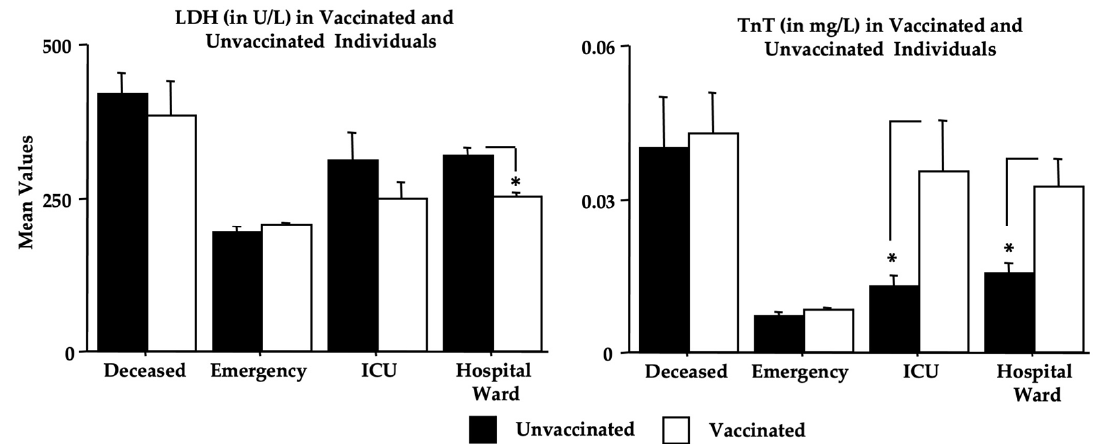
Figure 8. The vaccination effect is expressed as the number of doses of the vaccine. The error bars indicate pooled standard error means (SEM) derived from the appropriate error mean square in the ANOVA. The asterisks (* p < 0.05) indicate post hoc differences between groups.